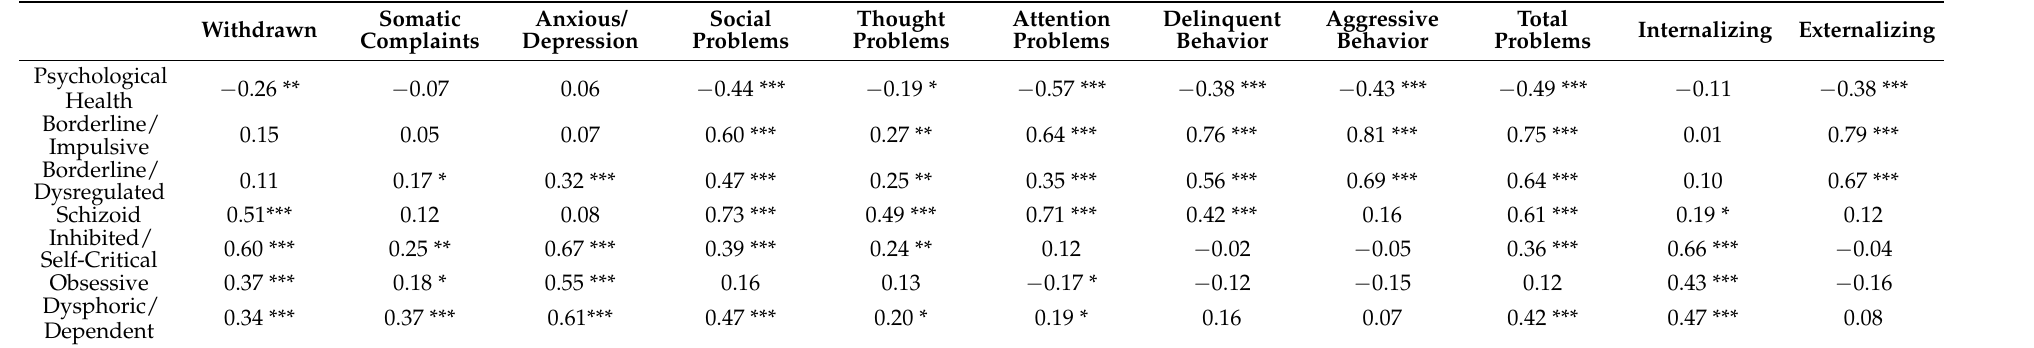
Table 10. Correlations between CPAP-Q a personality prototypes and CBCL b